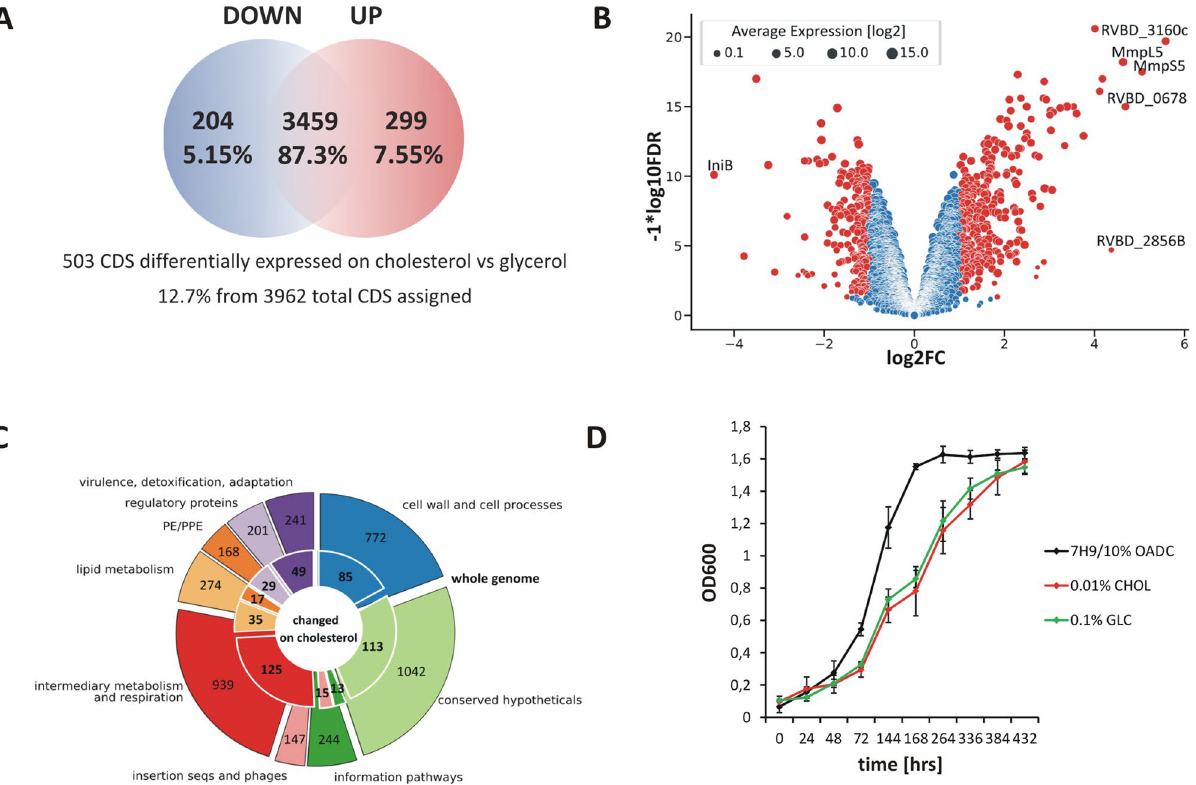
Figure 1. Summary of RNA sequencing results and growth characteristics of M. tuberculosis grown on cholesterol as the sole carbon source versus glycerol used as a control. ( A ) Venn diagram. A total of 503 differentially expressed CDSs were found. Among the 3962 CDSs assigned, 204 genes with decreased and 299 with increased expression were identified in the presence of cholesterol as the sole carbon source ( B ) Volcano plot. The negative log of false discovery rate (FDR) (base 10) is plotted on the Y-axis, and the log of the fold change (FC) (base 2) is plotted on the X-axis. The red points represent transcripts that are differentially expressed on cholesterol (FC > 1 and FDR < 0.05). The blue points represent transcripts that are not differentially expressed. The log average expression level (base 10) correlates with the size of individual points. ( C ) Donut plot. Protein functional categories were assigned to each transcript carrying information for protein synthesis. The number of genes with a change in expression observed for the individual categories (inner part of the chart) is plotted against the total number of transcripts encoding proteins belonging to the given category (outer part of the chart). Functional categories were assigned according to Mycobrowser (www. mycob rowser. epfl. ch, former Tuberculist). ( D ) Growth rate characteristics of the Mtb wild-type strain on 7H9/10% OADC medium and mineral medium supplemented with 0.01% cholesterol or 0.1%